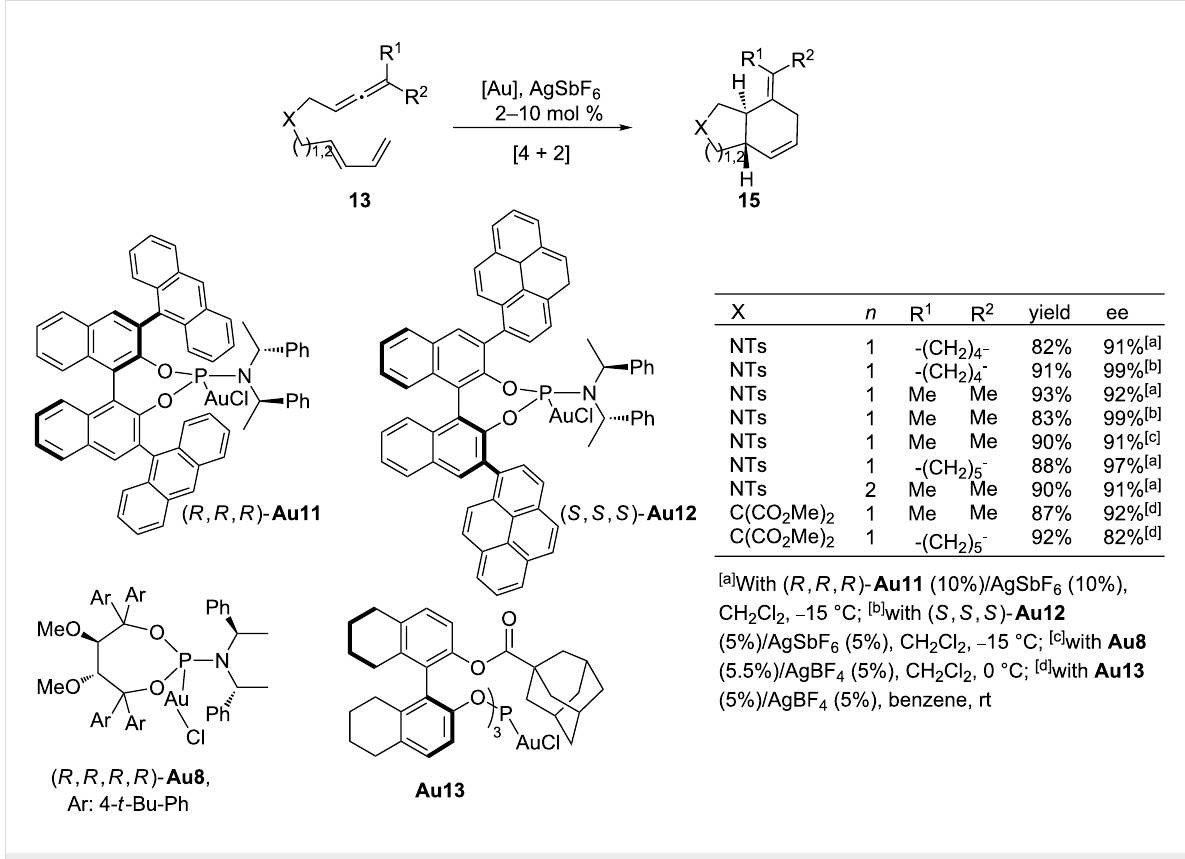
Scheme 9: Gold-catalyzed enantioselective [4 + 2] cycloadditions of allenedienes.